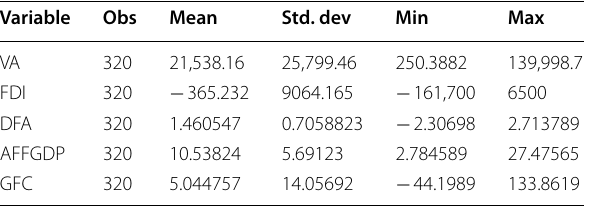
Table 1 Summary statistics